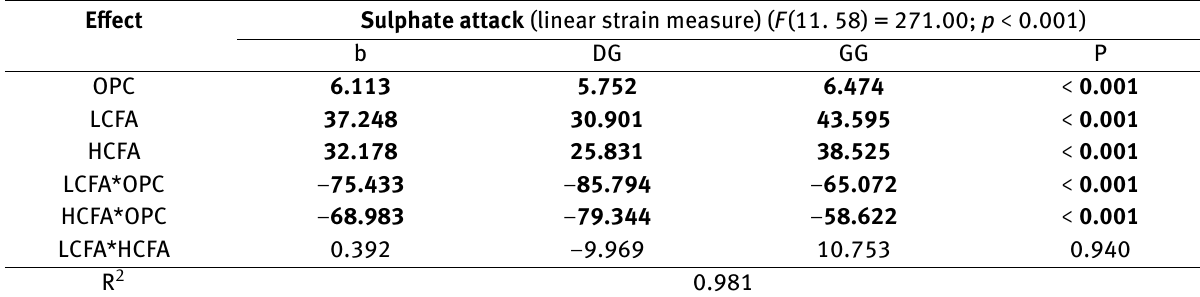
Table 3: Multiple linear regression model depending on the composition of cement bond binder after 170 days immersed in sulphate solution.